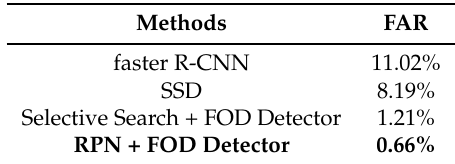
Table 3. The detection evaluations by FAR.